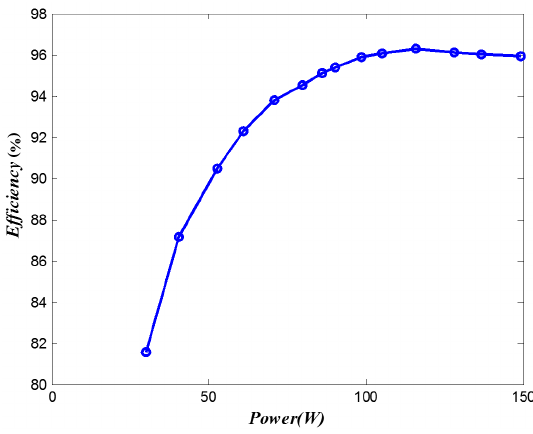
Figure 17. Measured efficiency curves. Table 2. Fair comparison to the other published methods.